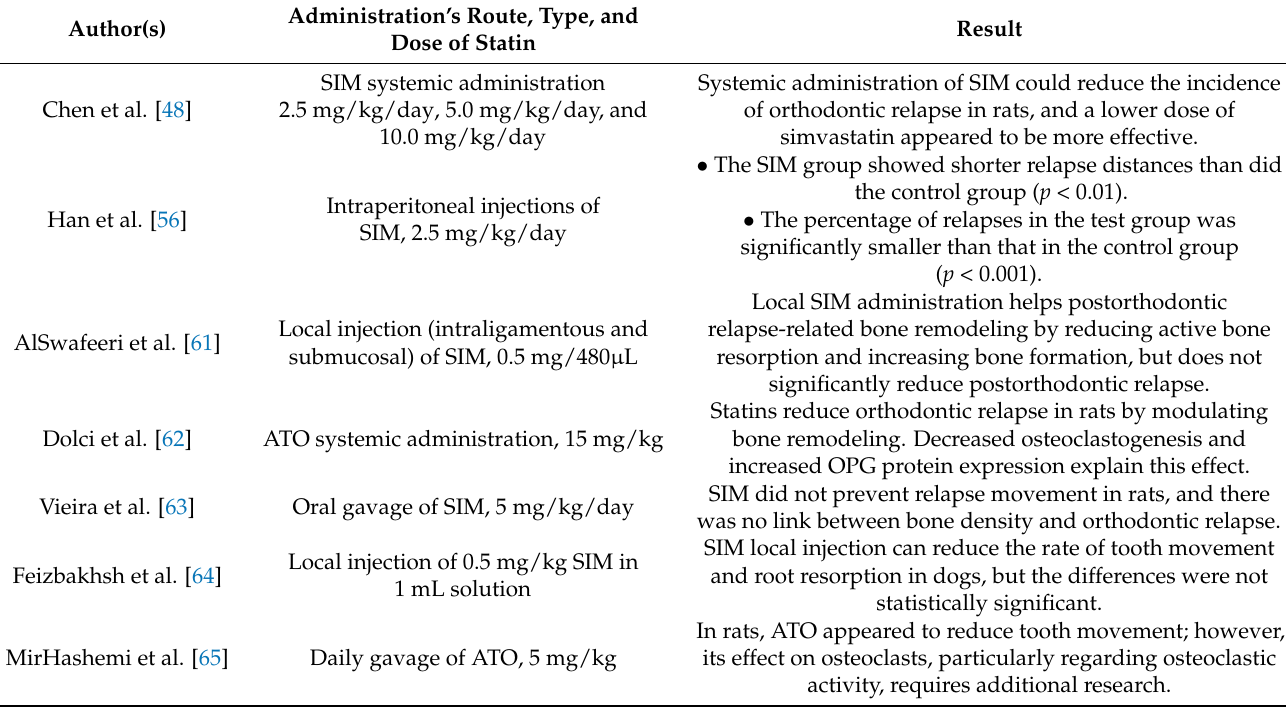
Table 1. The effect of statins in animal models of orthodontic